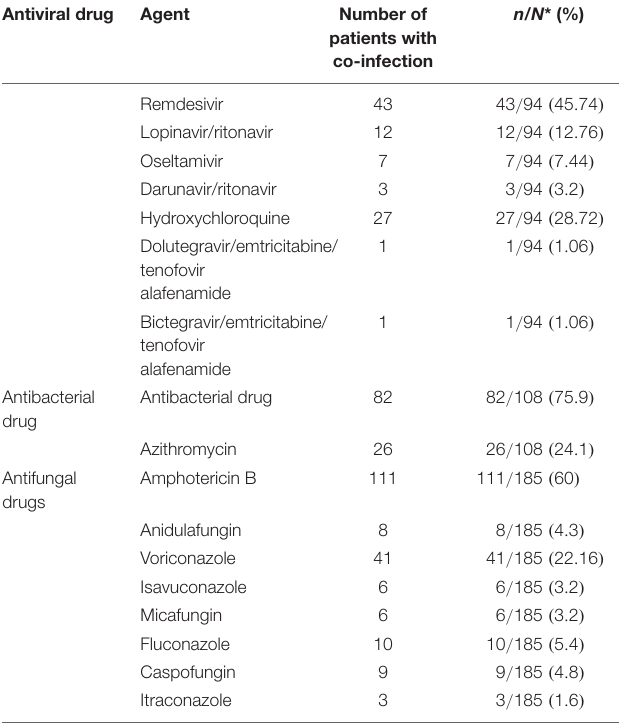
TABLE 6 | Agents used in the treatment of patients with fungal co-infection. Antiviral drug Agent Number of patients